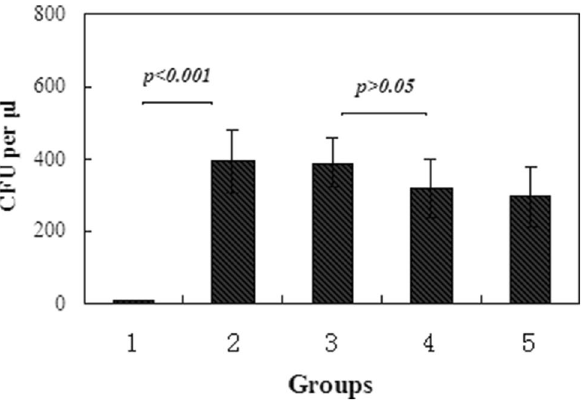
Figure 2. Colony formation unit (CFU) of bacteria was assayed as described in methods in five